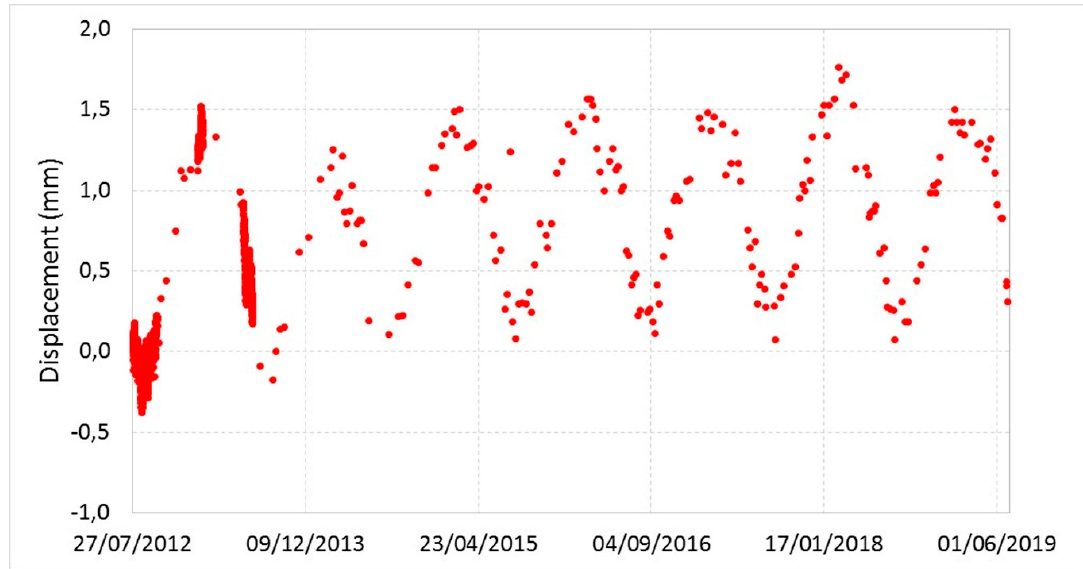
Figure 17. Displacement recorded by the crackmeter FS4 from 2012 to